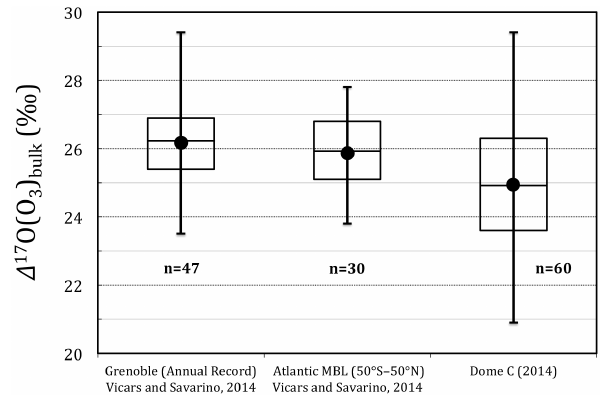
Figure 4. Comparison of (cid:49) 17 O(O 3 ) bulk values obtained at Dome C with those previously reported by Vicars and Savarino (2014) at other sites. Box plots indicate the interquartile range (box) and the median (line), maximum, and minimum values. The mean value is denoted by a